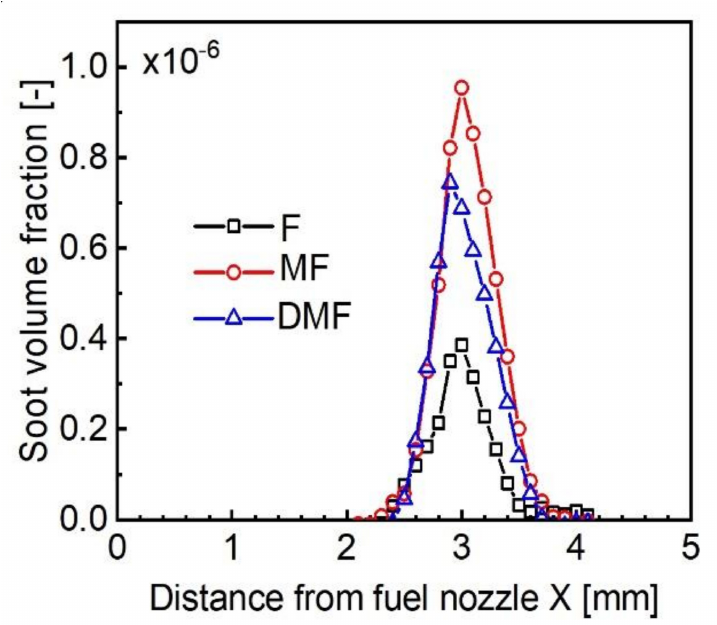
Figure 5. Profiles of the soot volume fraction for furan, MF, and DMF performed at the conditions of X F = 0.2 and X O =